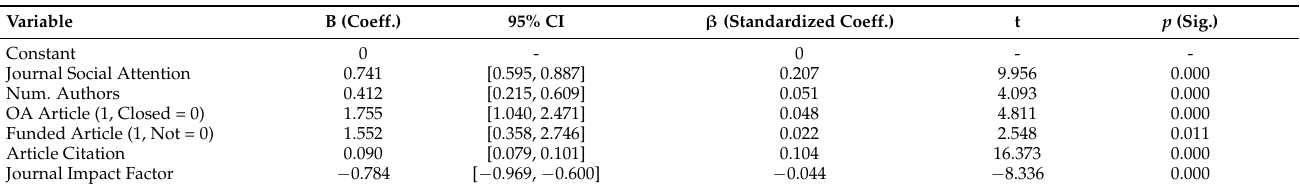
Table 5. Regression coefficients predicting Article Social Attention. Standard multiple linear regres- sion